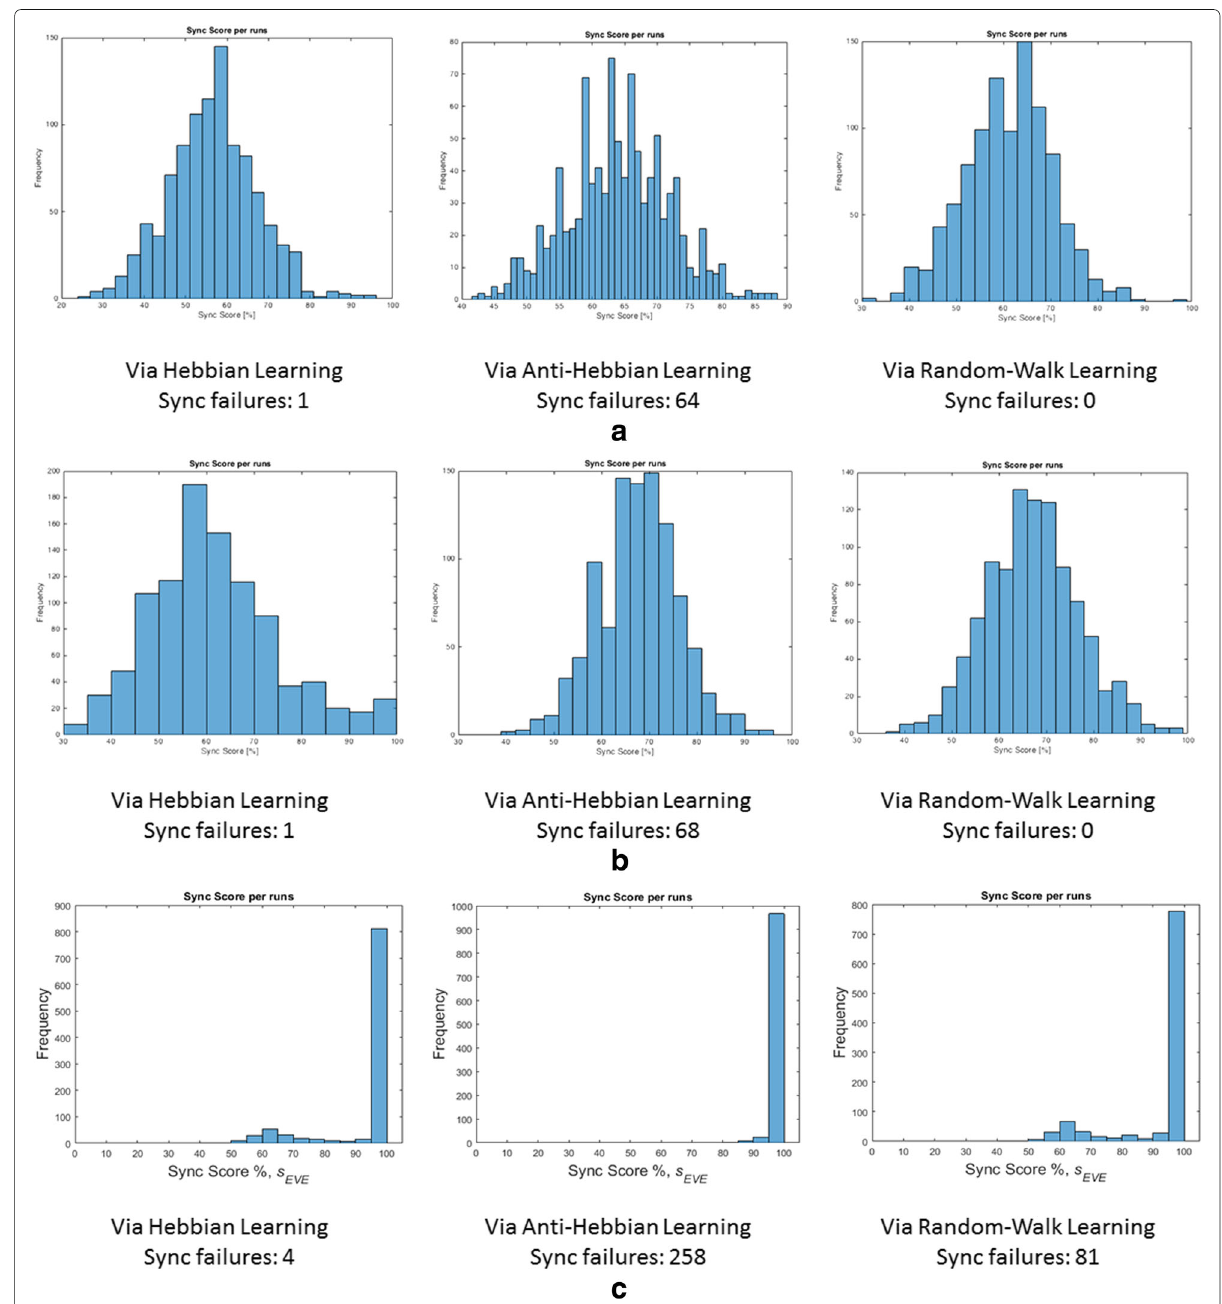
Fig. 5 Security evaluation cases. a Case 1: Eve syncs with Alice and Bob. b Case 2: Eve syncs only with Alice. c Case 3: Eve intercepts channel and acts as Alice or Bob